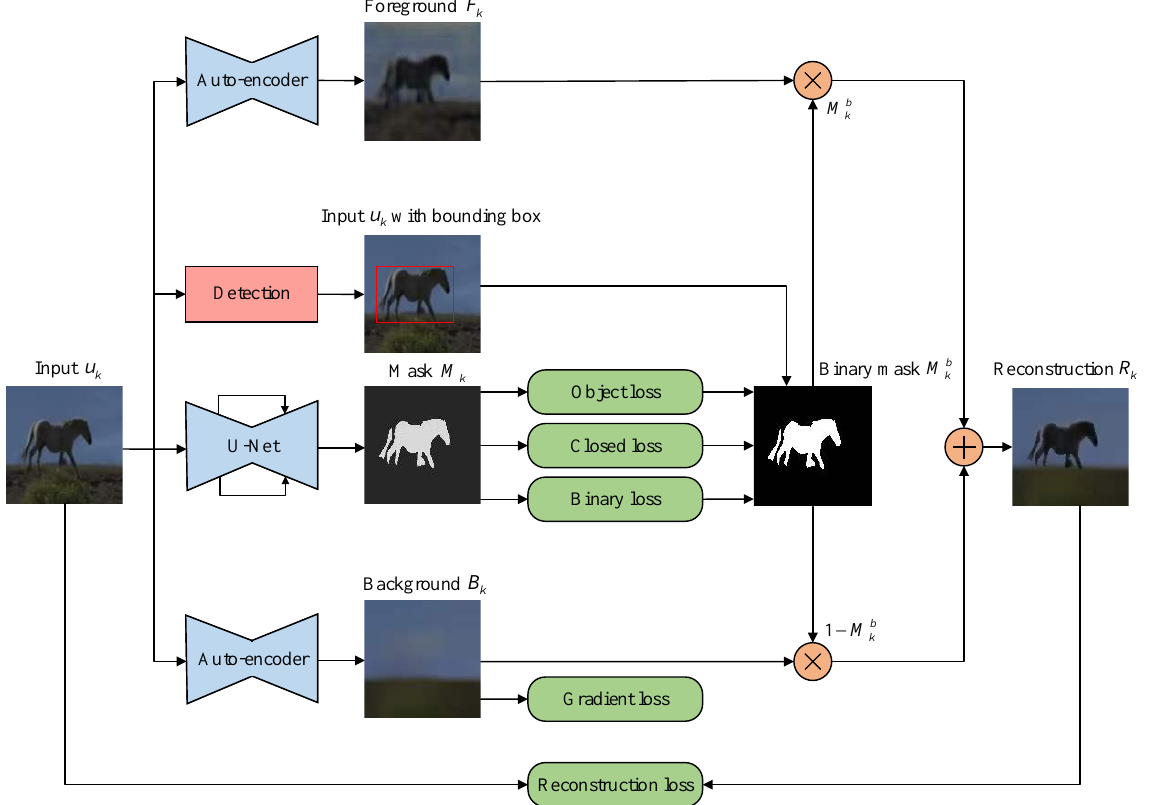
Figure 1. Overview of OLSeg. The model consists of the foreground and background branches with an autoencoder [28] respectively, and a mask branch with an U-Net [29]. The gradient loss in the background branch removes the foreground to great extent. The mask branch with bounding box prior uses an object loss, a closed loss and a binary loss. The outputs of the three branches work together to reconstruct the